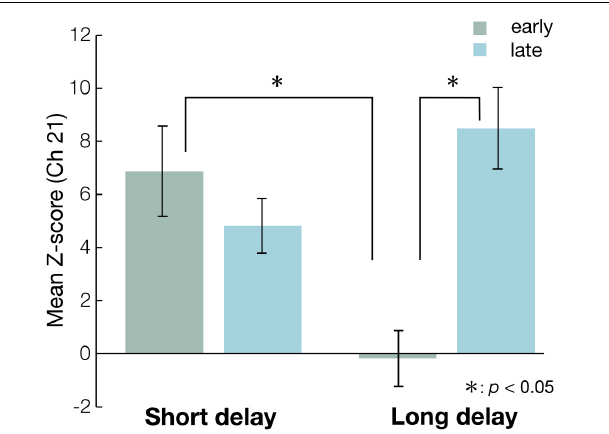
FIGURE 3 | The time course of the average change of Z-scores in the early and late periods (Ch21). The solid green line in the graph represents the time course of the average Z-score in the early period and the dashed blue represents the time course of the average Z-score in the late period. The shaded regions of green and blue indicate 95% confidence intervals. The gray shaded region represents statistical analysis time-window (short delay condition: 8–10.2 s, long delay condition: 8–11.4 s).